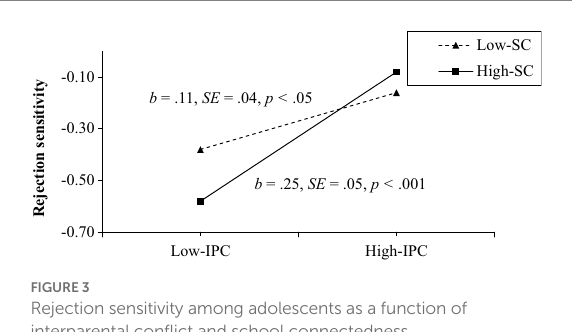
FIGURE 3 Rejection sensitivity among adolescents as a function of interparental conflict and school